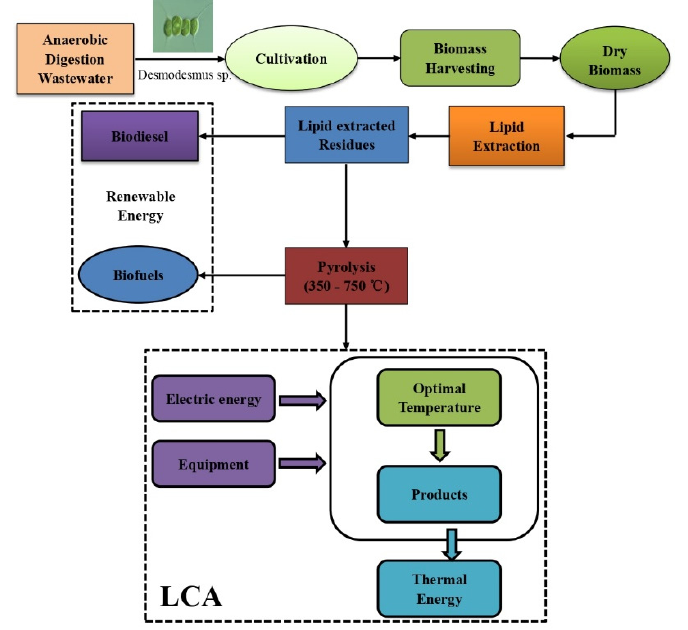
Figure 1. Process route and system boundaries of the LCA model for pyrolysis products of microalgal residues.